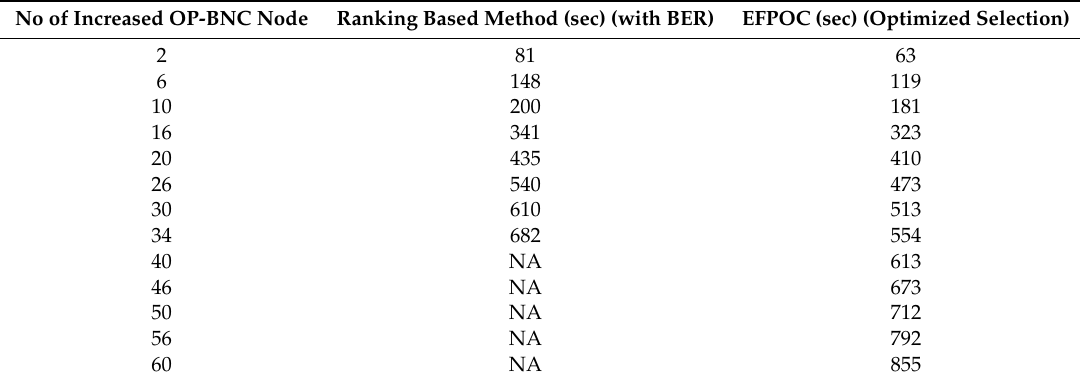
Table 4. Comparison of a simulated value for the number of channels and the time taken to select the channel for the optimized algorithm and an existing